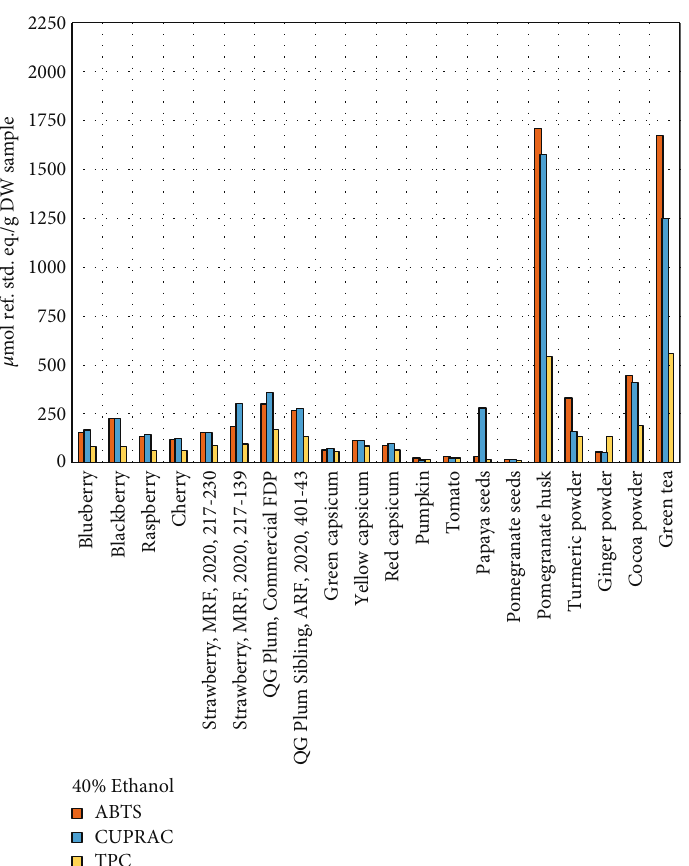
Figure 7: Comparison of ABTS, CUPRAC, and TPC assays in 40%